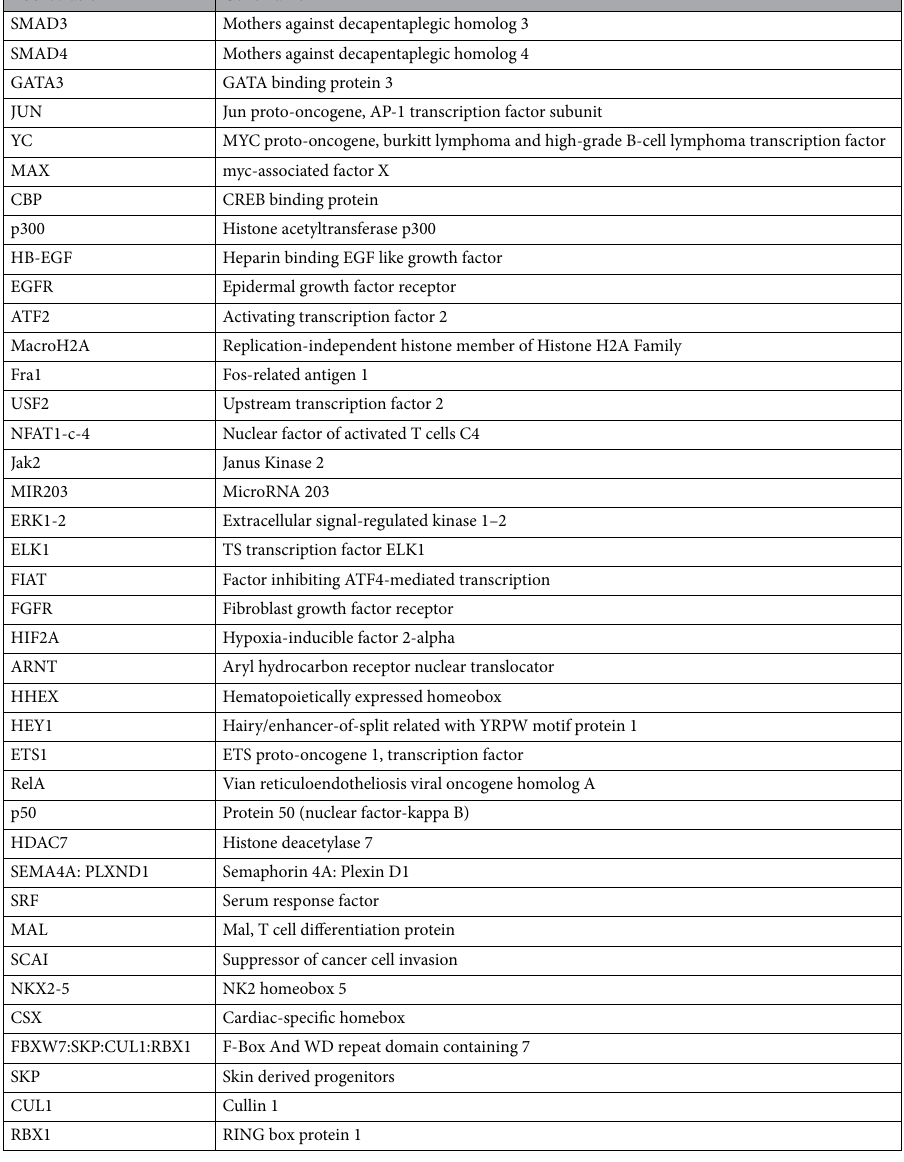
Table 4. Intermediate node complex genes and their